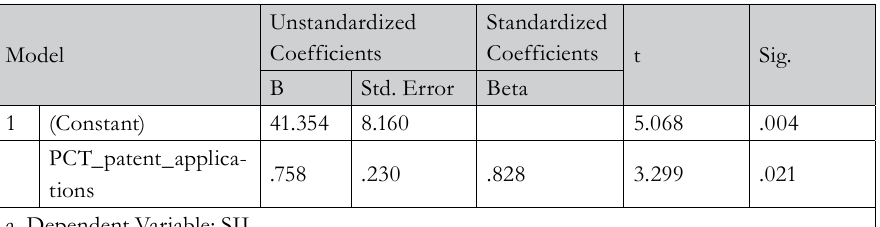
Tab. 5 – Coefficients a – Slovakia. Source: own processing